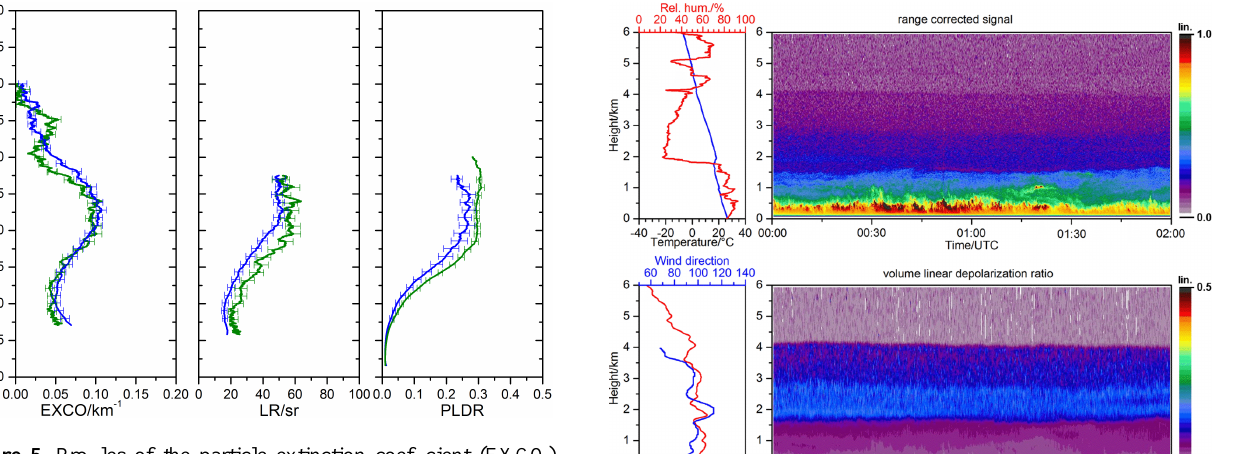
Figure 5. Profiles of the particle extinction coefficient (EXCO), the lidar ratio (LR) and of the particle linear depolarization ratio (PLDR) of the pure dust layer at 355nm (blue) and 532nm (green) on 20 June 2013, 23:30–24:00UTC. The error bars indicate the sys- tematic errors.